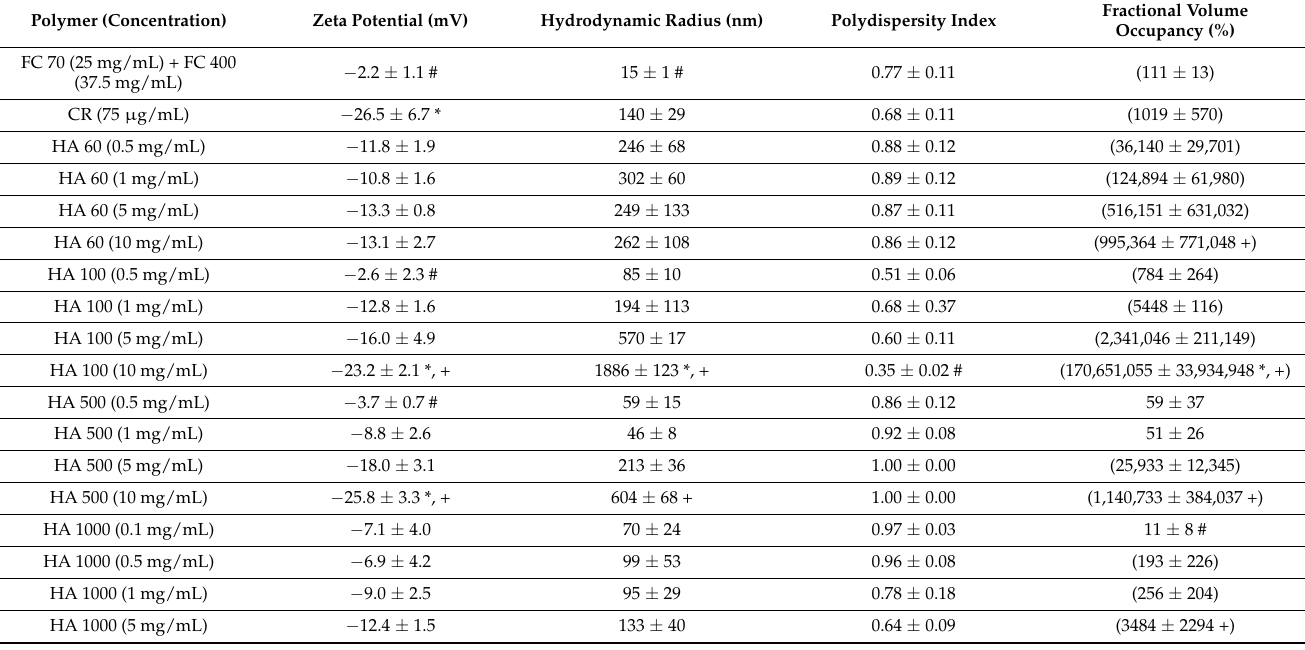
Table 1. Dynamic light scattering